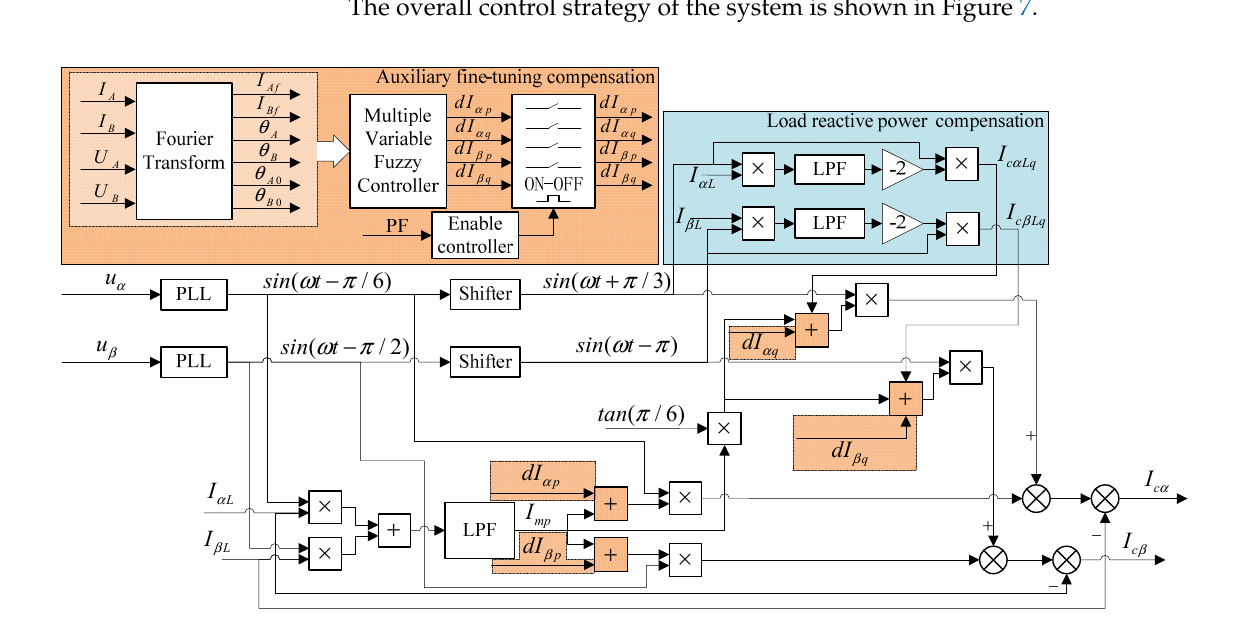
Figure 7. Overall control strategy of the system.